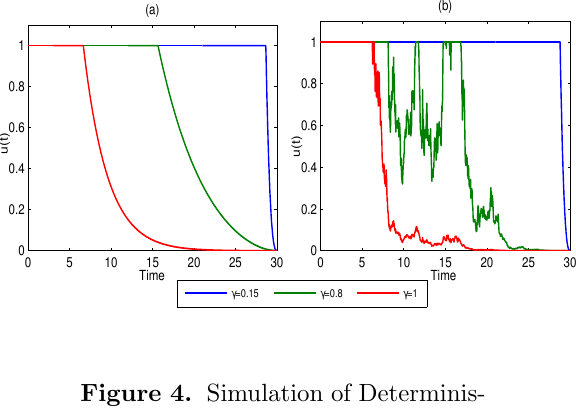
Figure 4. Simulation of Determinis- tic ( a ) and Stochastic ( b ) control pro- file for different values of recovery rate γ .